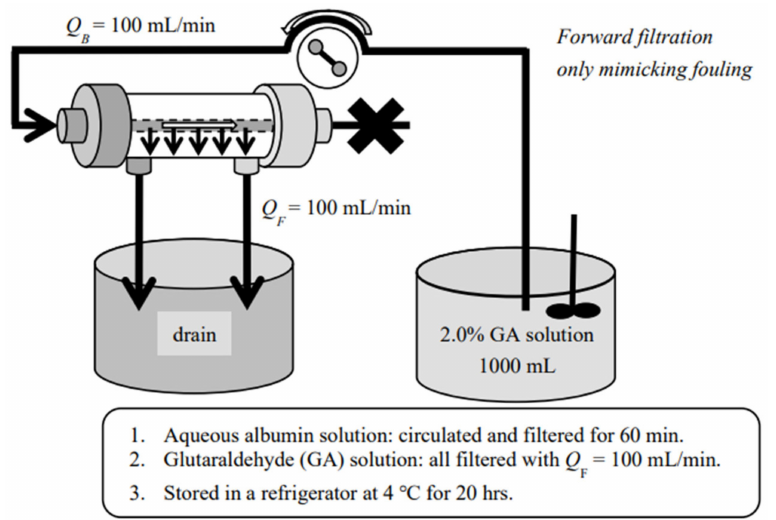
Figure 3. Immobilization of albumin on the dialysis membrane. Table 2. Chemicals used in the